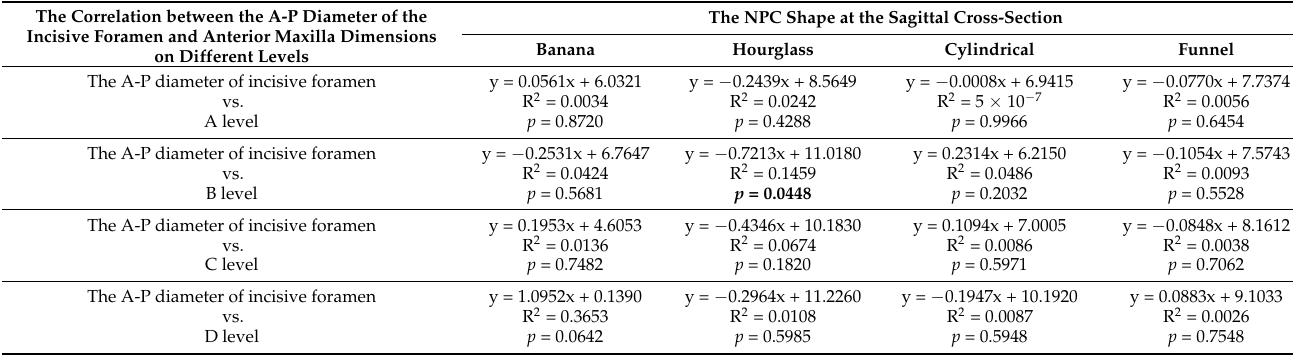
Table 4. The correlation between the A-P diameter of the incisive foramen and anterior maxilla dimensions at predefined portions depending on the canal shape at the sagittal cross-section.